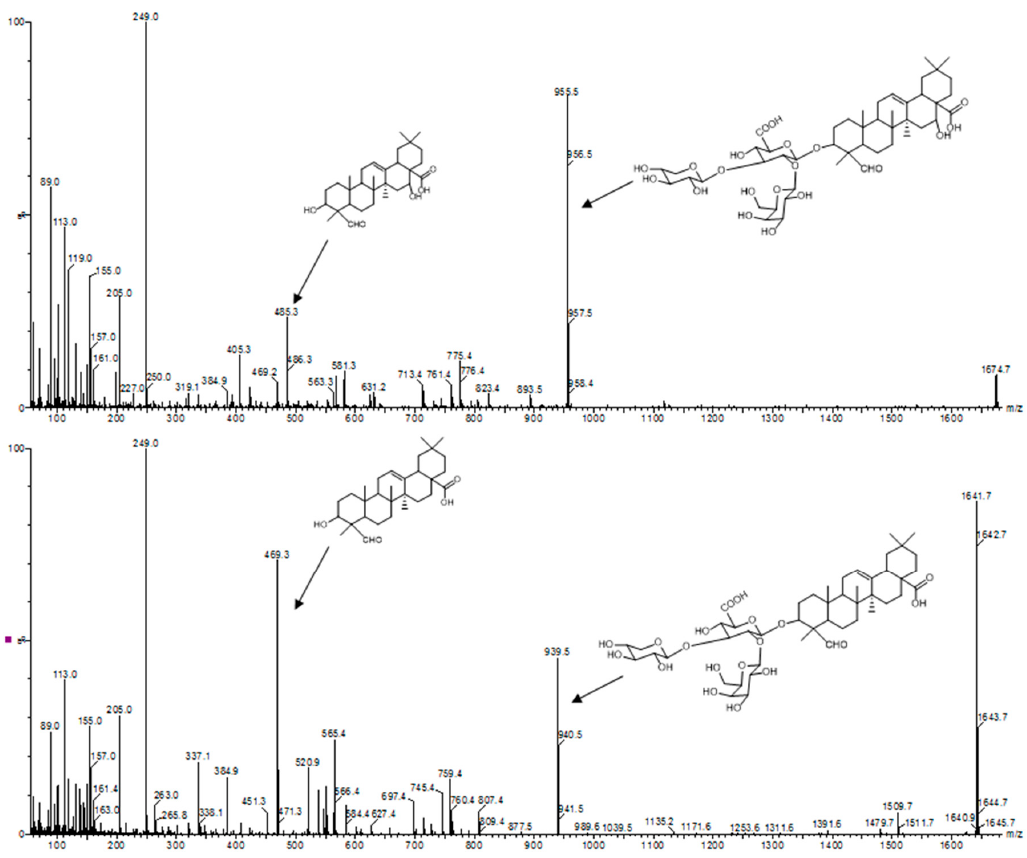
Figure 3. Tandem mass spectra of triterpene saponins. The triterpene saponin with m / z 1674 (SO1674) was isolated by countercurrent chromatography from the roots of Saponaria officinalis L. The triterpene saponin with m / z 1641 (SA1641) was isolated by HPLC from Saponinum album (Merck, Darmstadt, Germany). The identification of the aglycones of SO1674 (quillaic acid) and SA1641 (gypsogenin) was based on the fragmentation pattern. The peaks at m / z 955 and 939 were assigned to the prosapogenic parts of the bisdesmosidic saponins.